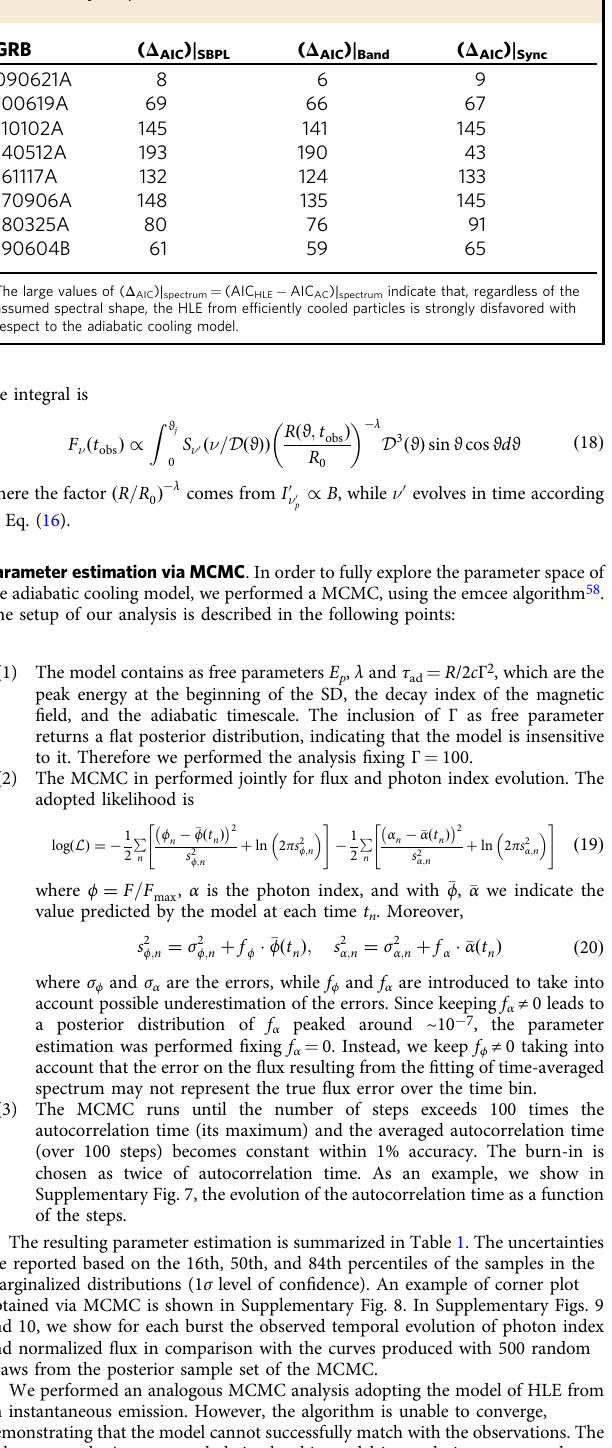
Table 2 Comparison of best fi t statistics between adiabatic cooling (AC) and HLE, adopting a SBPL, a Band function or a synchrotron spectrum, using the Akaike information criterion (AIC). GRB